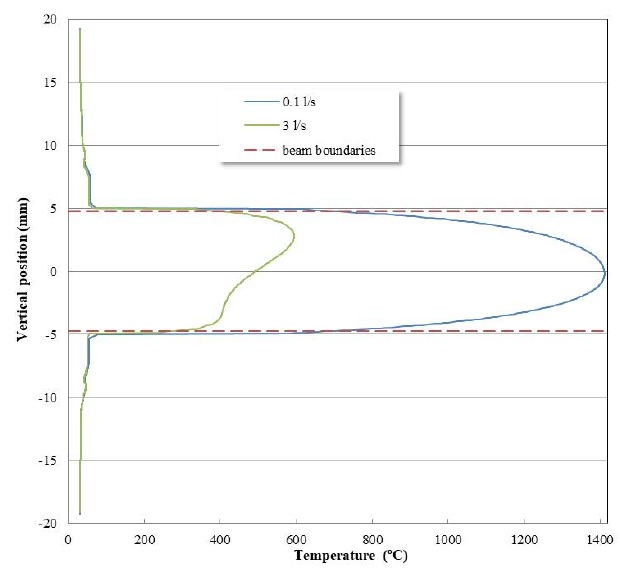
Figure 11. Temperature of the target window on its surface in contact with the liquid target for helium cooling fluxes of 0.1 and 3 L/s.